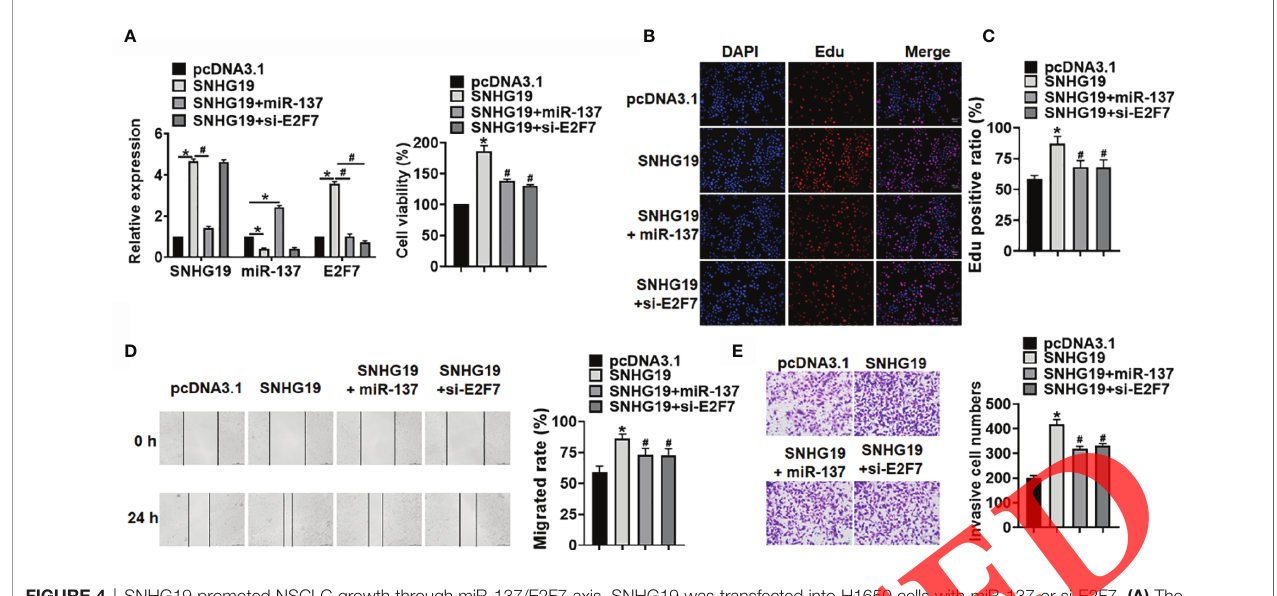
FIGURE 4 | SNHG19 promoted NSCLC growth through miR-137/E2F7 axis. SNHG19 was transfected into H1650 cells with miR-137 or si-E2F7. (A) The transfection ef fi ciency was detected using qRT-PCR. (B) MTT analysis for cell viability of H1650 cells. (C) Edu assay for cell proliferation of H1650 cells. Scale bar, 20 m m. (D) Wound healing assay for cell migration of H1650 cells. Scale bar, 100 m m. (E) Transwell assay for cell invasion of H1650 cells. Scale bar, 50 m m. Data are mean ± SD; *P < 0.05 vs pcDNA3.1, # P < 0.05 vs SNHG19. All experiments were repeated three times.